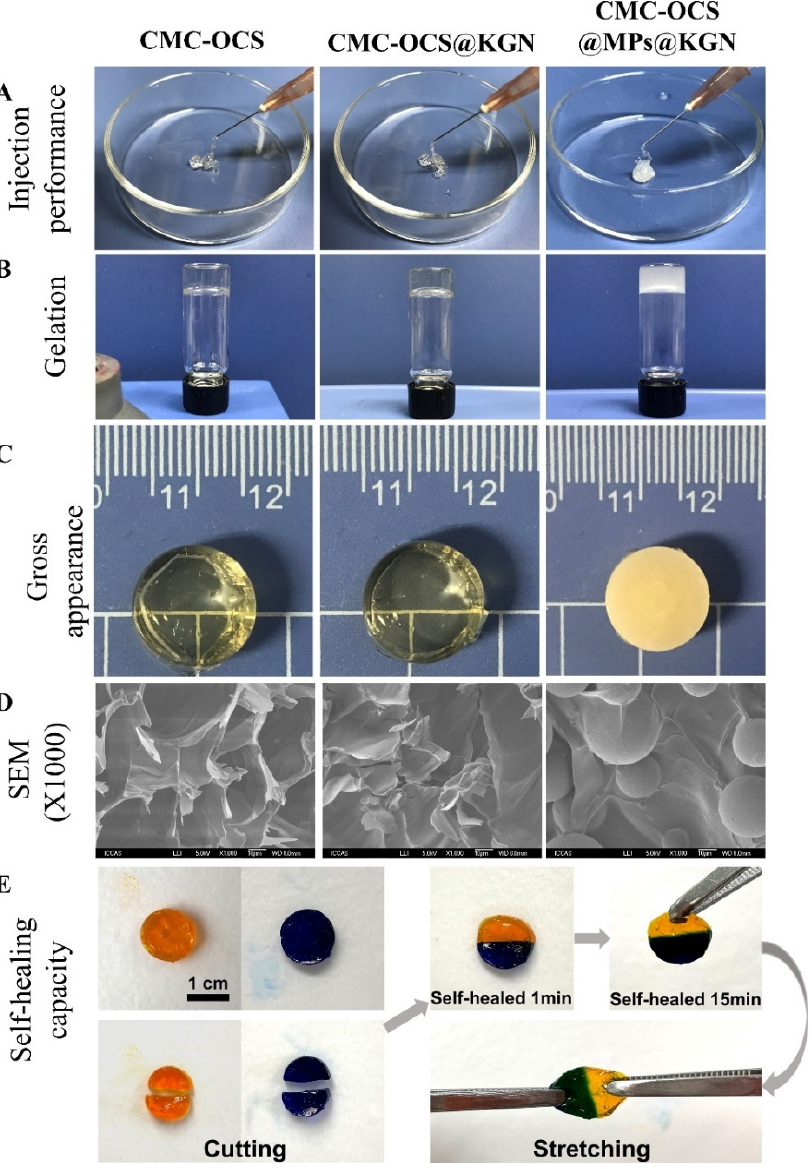
Figure 3. ( A ) The extrusion from a conventional medical syringe showing the injection performance of hydrogel scaffolds. ( B ) Gelation process of scaffolds. ( C ) Gross performance of scaffolds. ( D ) Cross-sectional SEM photographs showing the interconnected porous structure of scaffolds. ( E ) Demonstration on self-healing capacity by cutting hydrogel into halves and rejoining them with each other to achieved healed interfaces.